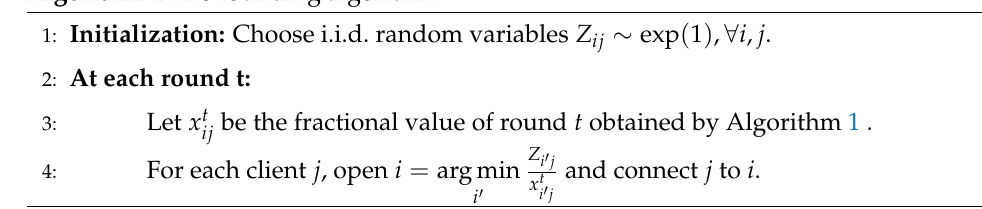
Algorithm 2 The rounding algorithm